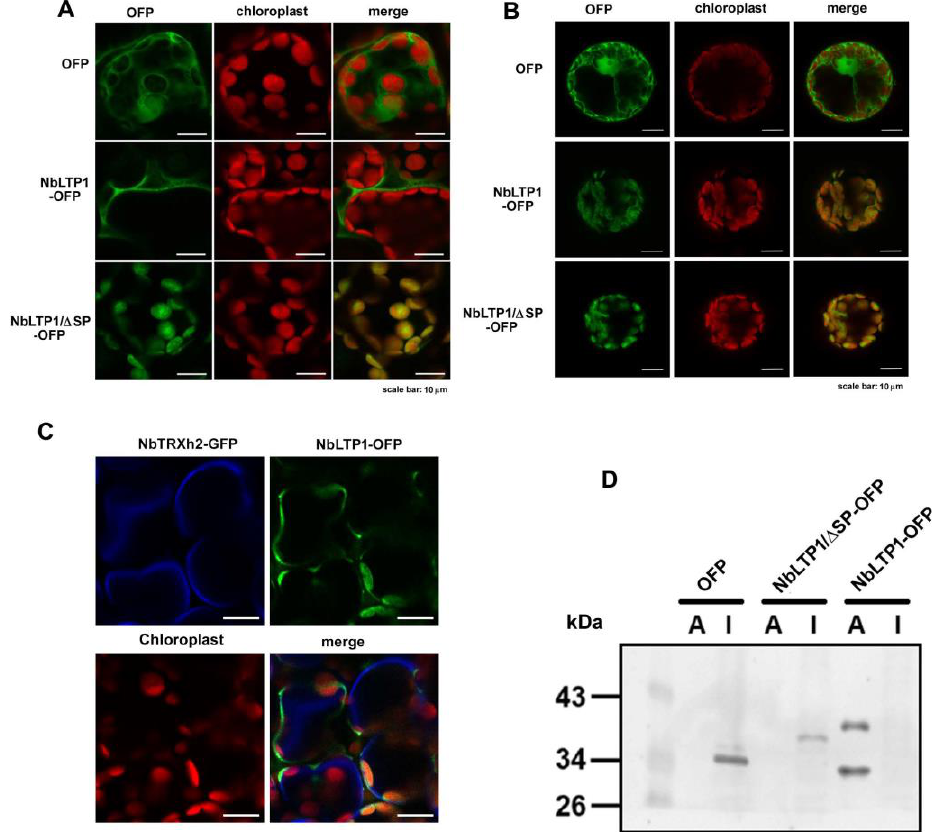
Figure 3. Subcellular localization and the Western blot analysis of the expression of NbLTP1-OFP and NbLTP1 / ∆ SP-OFP in N. benthamiana leaves. OFP-fused NbLTP1 and NbLTP1 / ∆ SP were transiently expressed in N. benthamiana leaves ( A ) and protoplasts ( B ). Images were obtained under an Olympus Fluoview FV1000 confocal microscope with 543 nm and 633 nm laser excitation. Scale bar is 10 µ m. ( C ) High-resolution images with the plasma membrane marker (NbTRXh2-GFP) were obtained under an Olympus Fluoview FV3000 confocal microscope. Scale bar is 10 µ m. ( D ) The infiltrated leaves were collected and vacuum-infiltrated with a bu ff er. The apoplastic fluid was collected indicated as A. The remaining tissue after removing the apoplastic fluid indicated as I for intracellular. Total protein was extracted from the apoplastic fluid ( A ) and the intracellular tissue